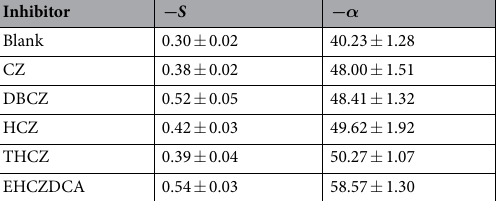
Table 4. The slopes ( S ) of the Bode impedance modulus plots at intermediate frequencies and the maximum phase angles ( α ) for mild steel in 1 M HCl solution in the absence and presence of 500 ppm inhibitors.